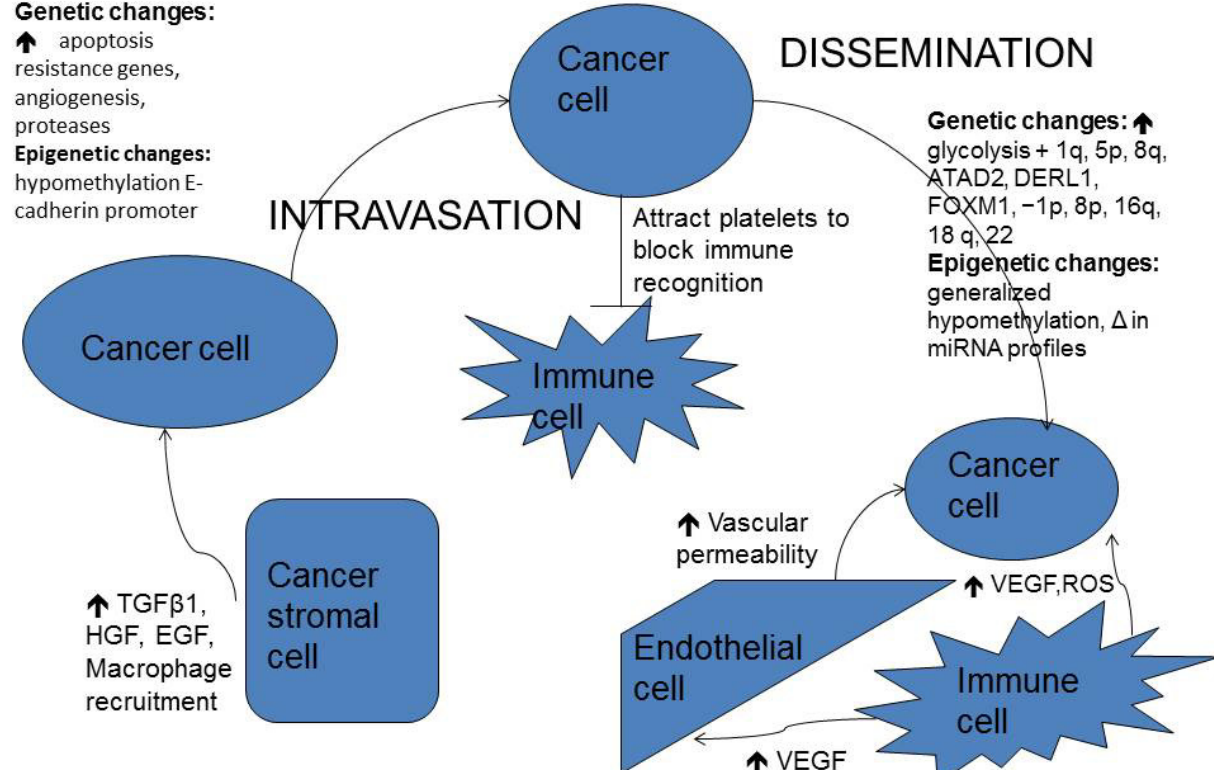
Figure 1. Overview of cancer cell interactions with stromal and immune cells, genetic and epigenetic changes during the metastatic